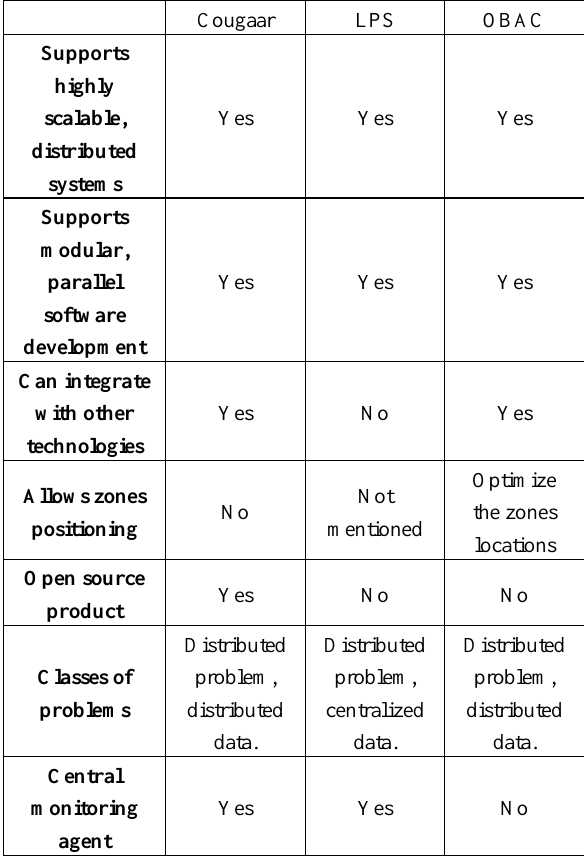
Table 1. Comparison between defense logistics